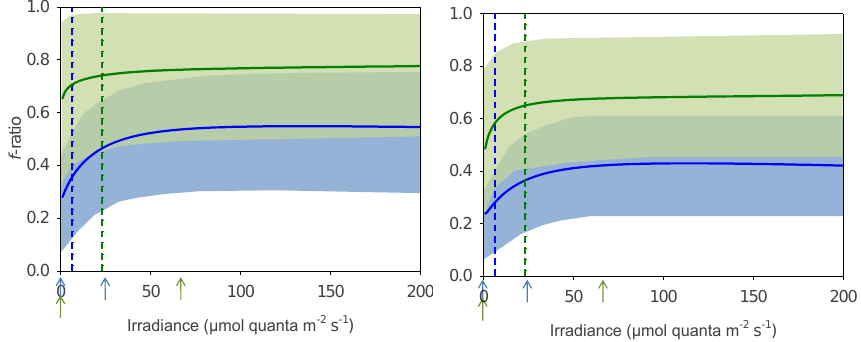
Fig. 6. Relationship between E k and E SCM for photosynthesis (blue circles) and the uptake of NO − during spring–early summer (left-hand side) and late summer–fall (right-hand side). The dashed vertical lines represent the mean E SCM for each season, and the dashed lines provide visual reference for 1:1 and 1:2 ratios.